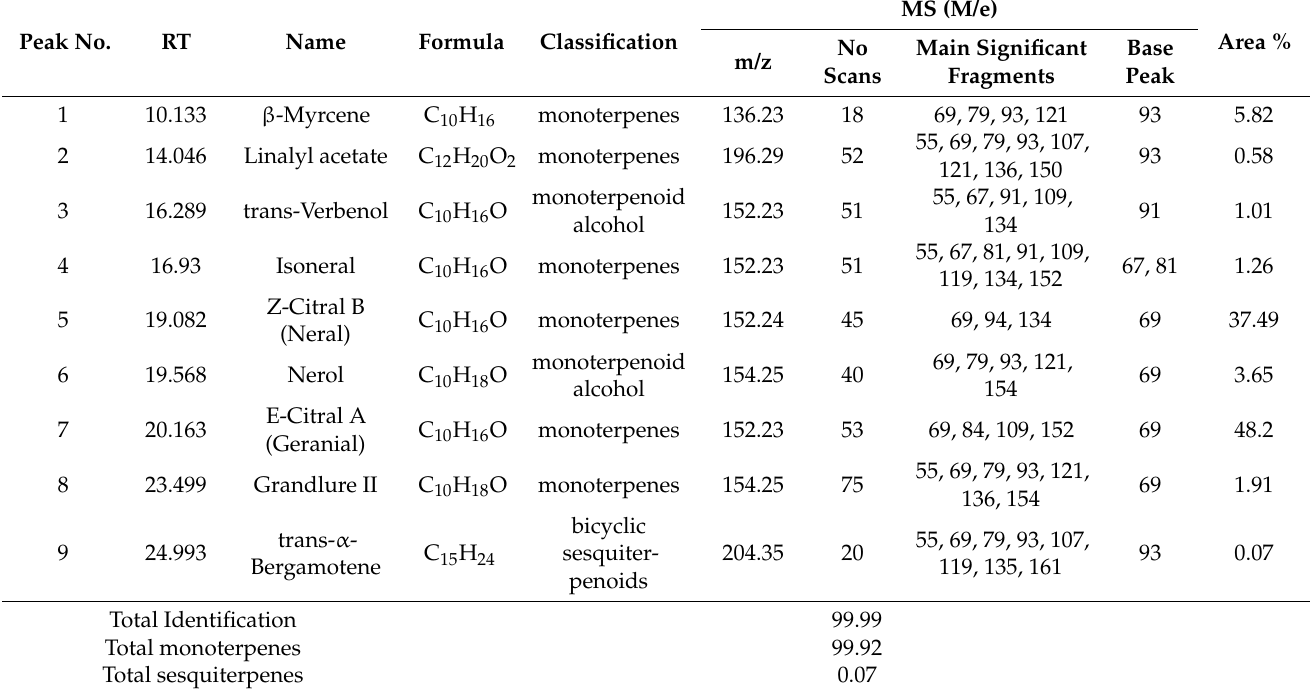
Table 1. The main constituents of Cymbopogon citratus EO.